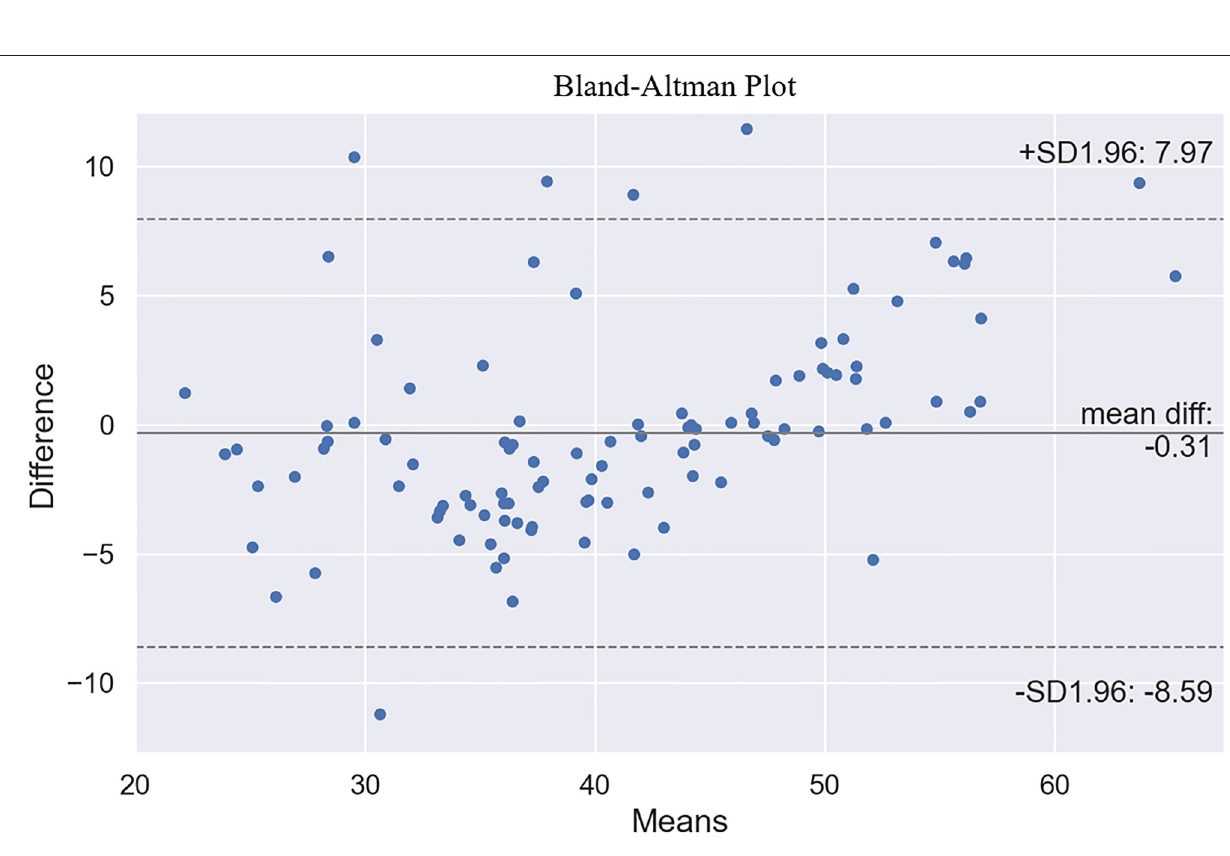
FIGURE 4 | Bland-Altman plot of true and predicted maximal oxygen